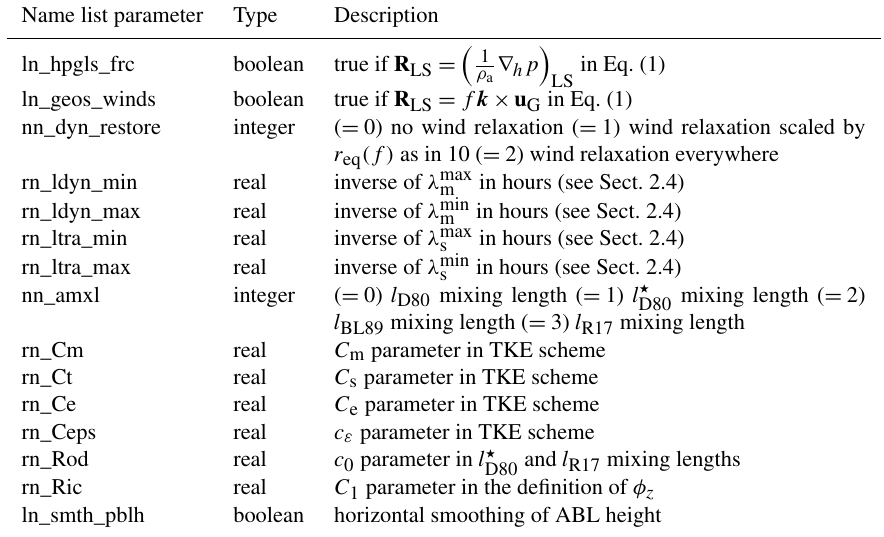
Table 3. Name list parameters in the NEMO(v4.0) to set in the name list section namsbc_abl before running a simulation coupled with